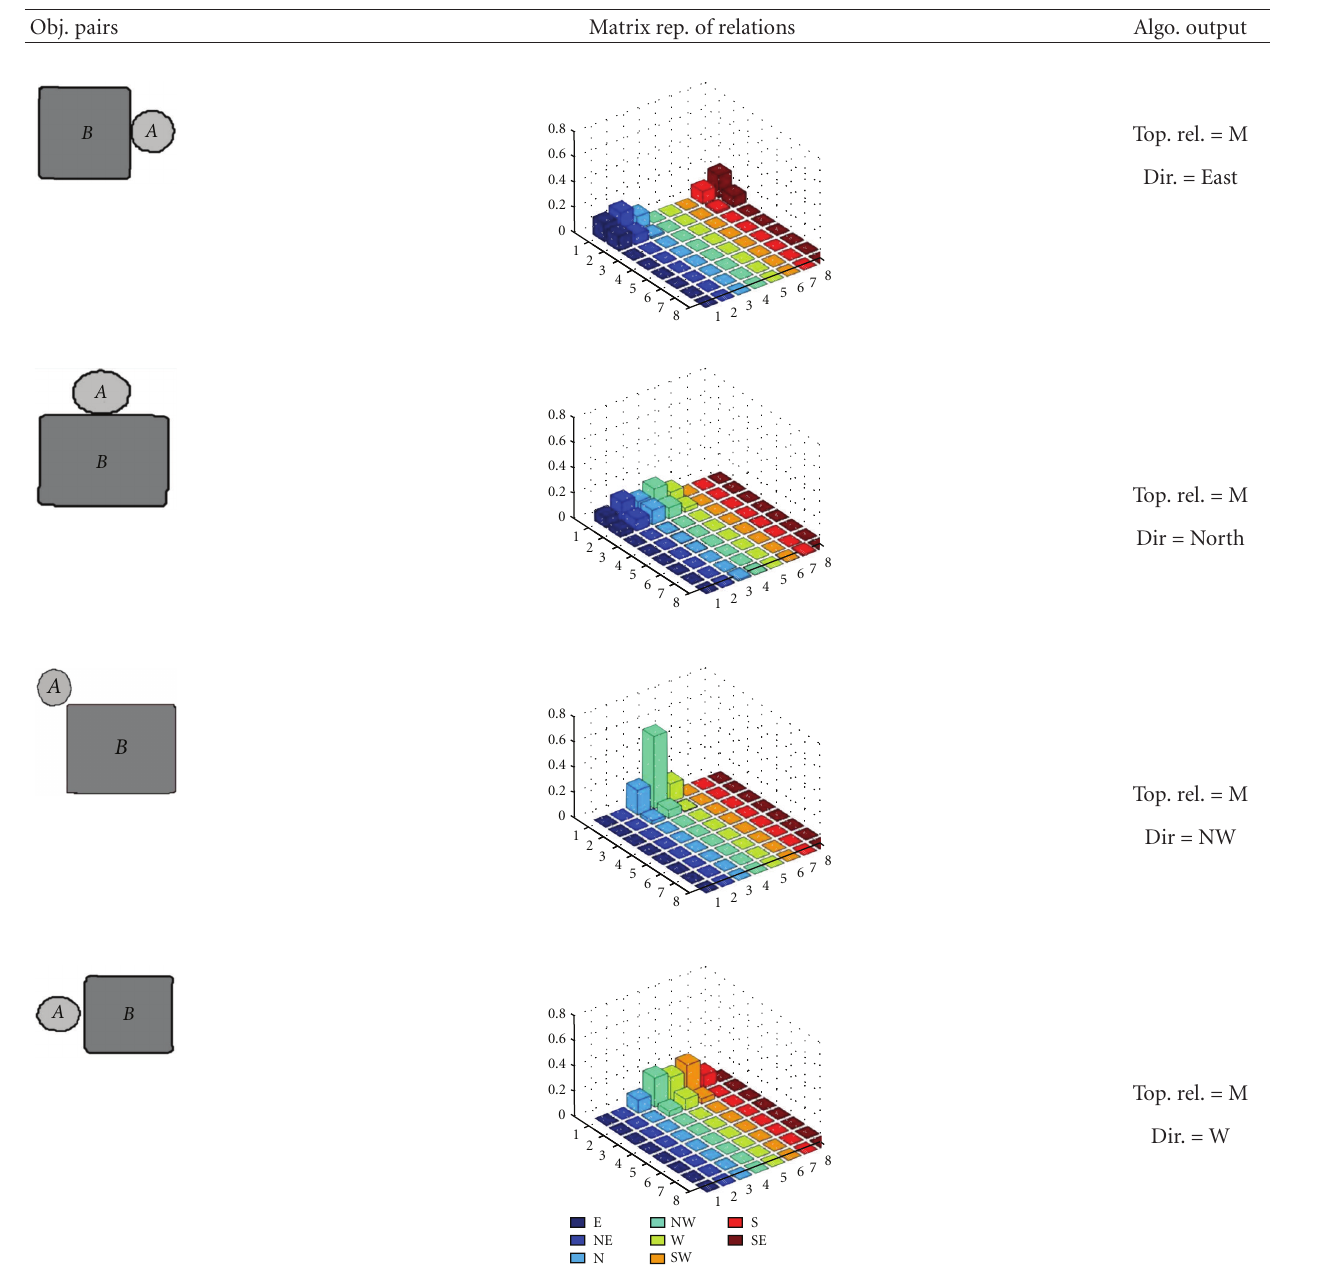
Table 3: Topological relation M.